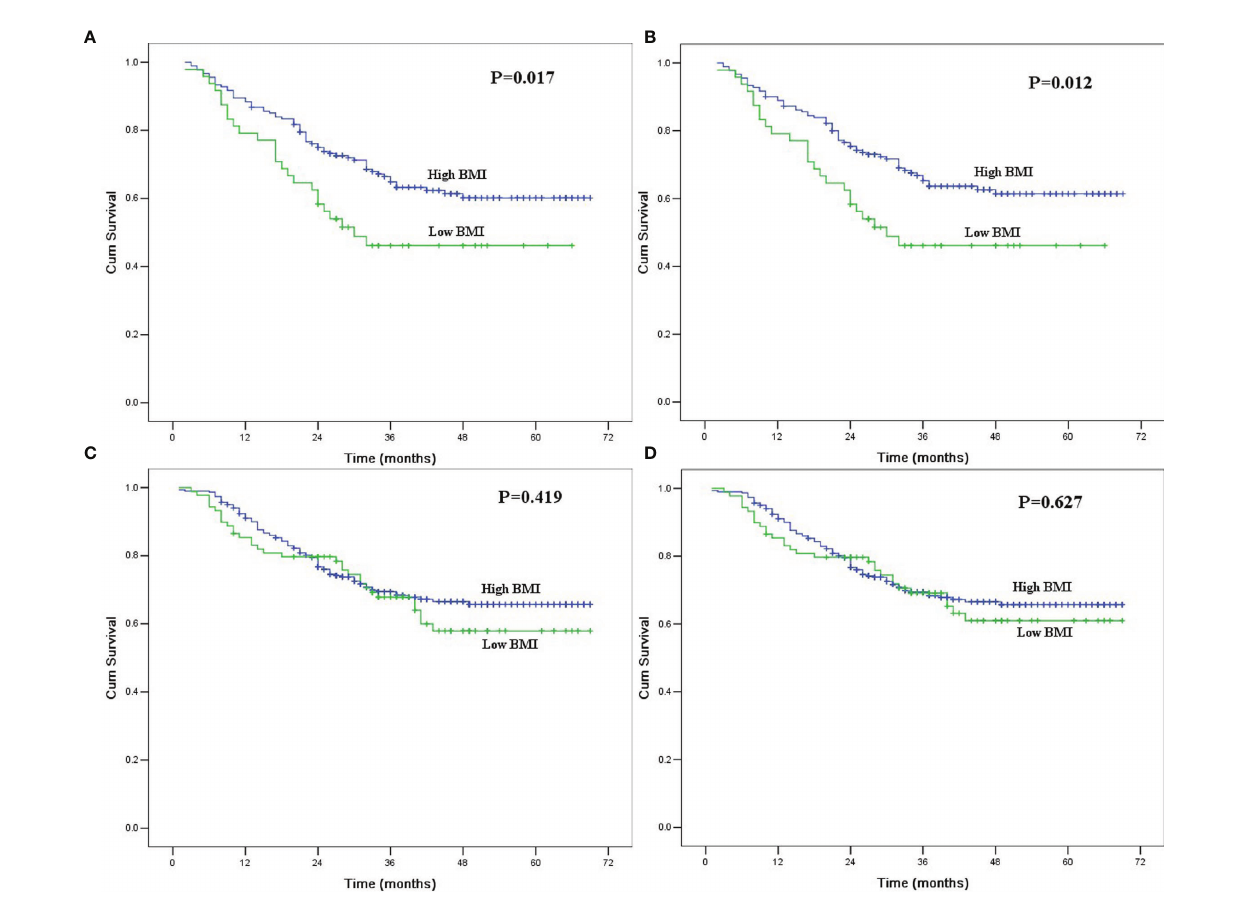
FIGURE 1 | (A) Overall survival in ever drinkers with esophageal squamous cell carcinoma after esophagectomy according to body mass index. The difference was signi fi cant (P=0.017). (B) Cancer-speci fi c survival in ever drinkers with esophageal squamous cell carcinoma after esophagectomy according to body mass index. The difference was signi fi cant (P=0.012). (C) Overall survival in never drinkers with esophageal squamous cell carcinoma after esophagectomy according to body mass index. The difference was not signi fi cant (P=0.419). (D) Cancer-speci fi c survival in never drinkers with esophageal squamous cell carcinoma after esophagectomy according to body mass index. The difference was signi fi cant (P=0.627).